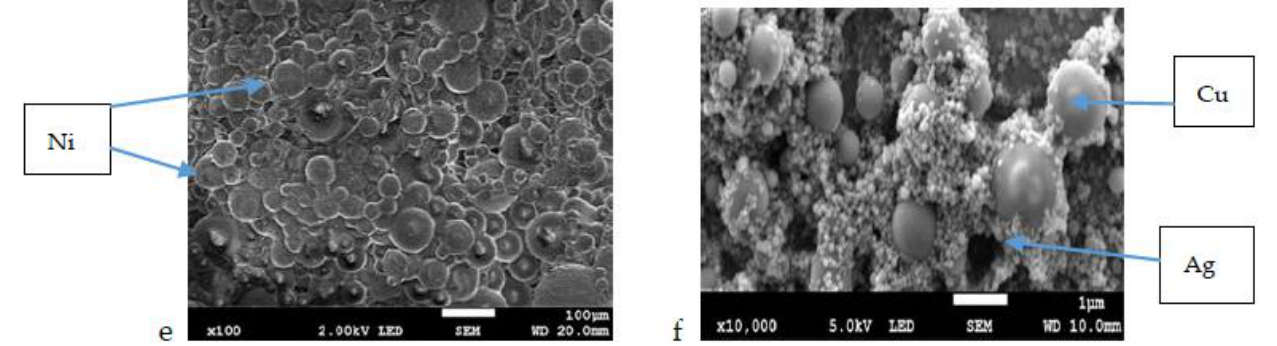
Figure 3. Results of the SEM evaluation of the surfaces of bone cement: ( a ) pure, and implemented with ( b ) Ag; ( c ) Cu 10; ( d ) Cu 70; ( e ) Ni; ( f ) AgCu. The surfaces of specimens exposed for 1 day to liquid of different bacteria are shown in Figure 4a–f. After the short-time exposure, the surfaces of all samples were free of bacteria (Figure 4a–f).